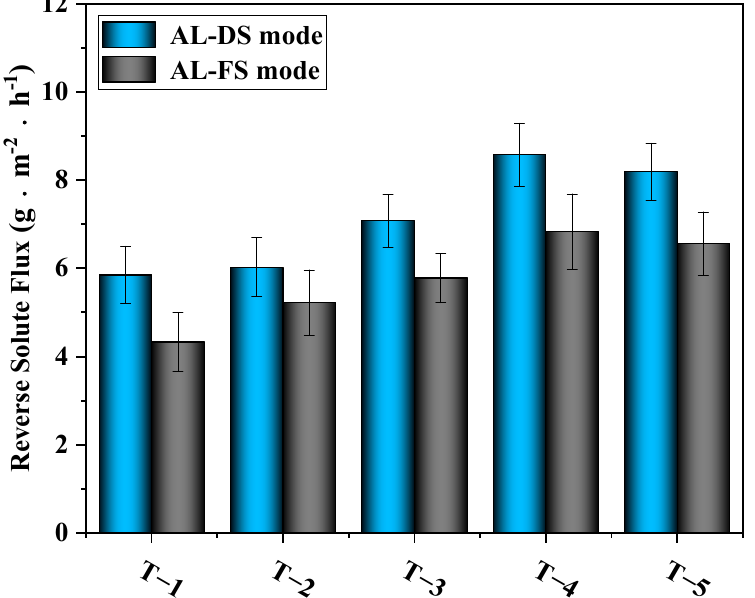
Figure 12. The effects of different amounts of MXene nano-sheets on the reverse solute flux of the TFC-FO membranes.